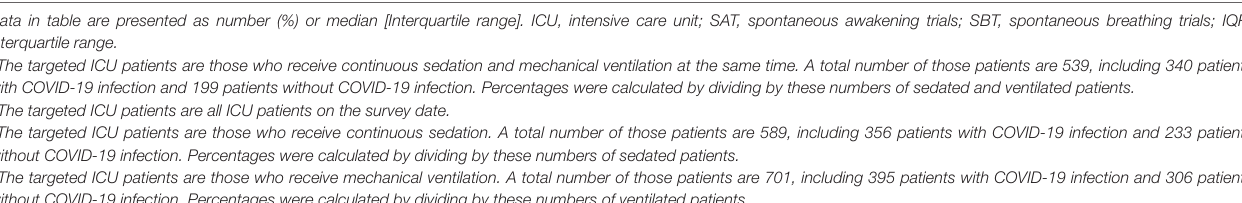
P -value The patients without The patients with ( n = 1,229) COVID-19 infection COVID-19 infection ( n = 627) ( n = 602)